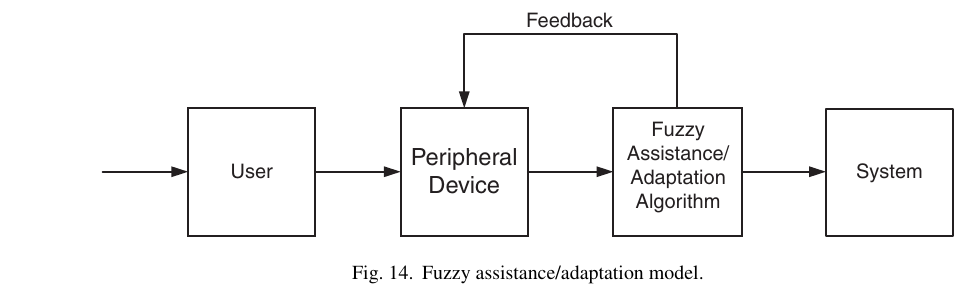
Fig. 14. Fuzzy assistance/adaptation model.